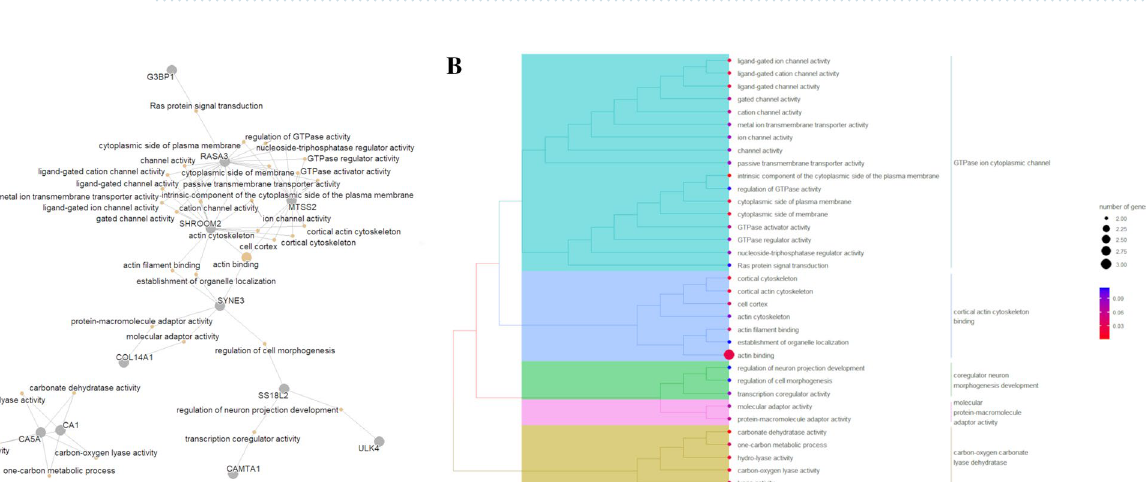
Table 4. Enrichment results for the gene ontology annotated for the genes harboring differentially methylated regions for all three terms of the multifactorial model (Nutchal * FatGroup, NutChal, and FatGroup).